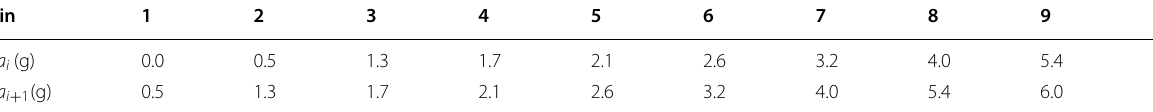
Table 3 Amplitude range of S